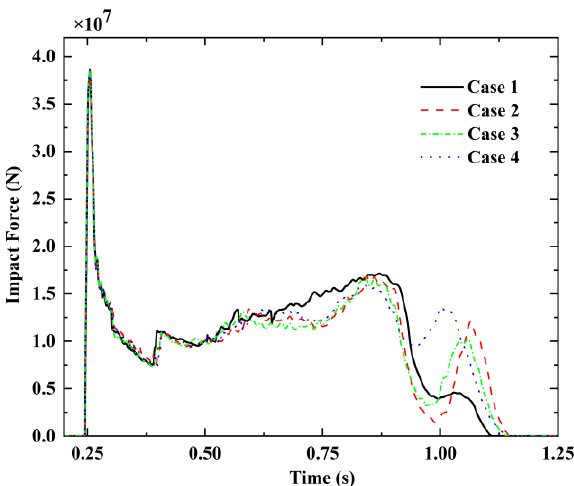
Figure 27. Impact forces in four simplified superstructure cases.